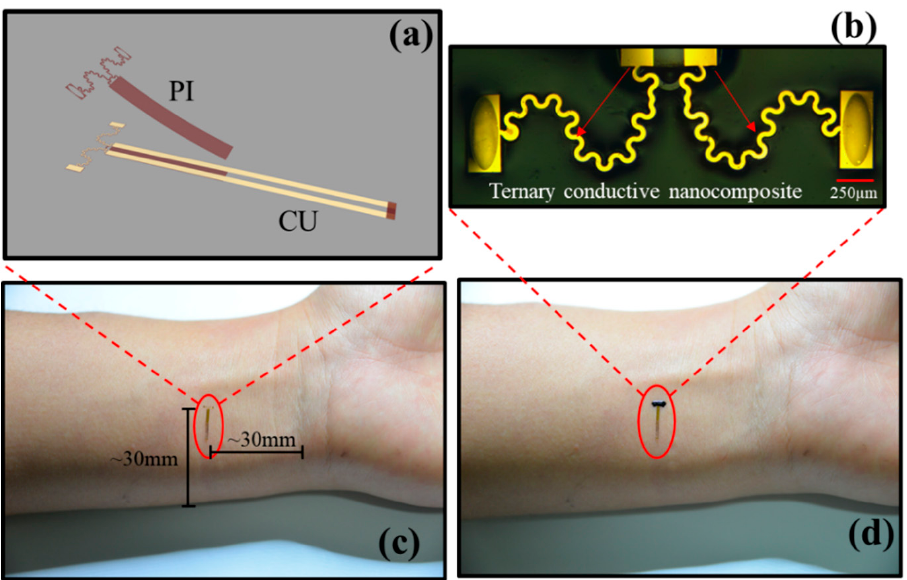
Figure 1. Illustration of the epidermis electronic sensor (EES): ( a ) Schematic illustration of the connector. ( b ) Enlarged image of the EES, the scar bar is 250 µ m. ( c ) Image of the two-stage serpentine connector located in human skin. ( d ) Image of the EES.